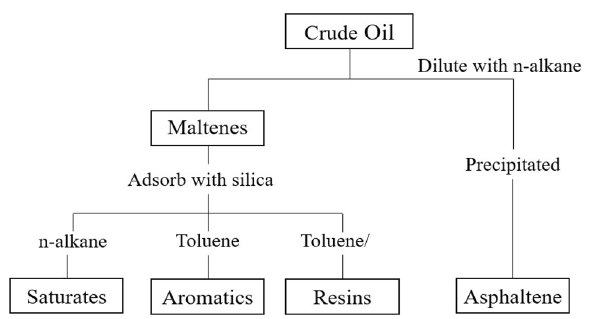
Fig. 1 The schematic of separating crude oils into SARA